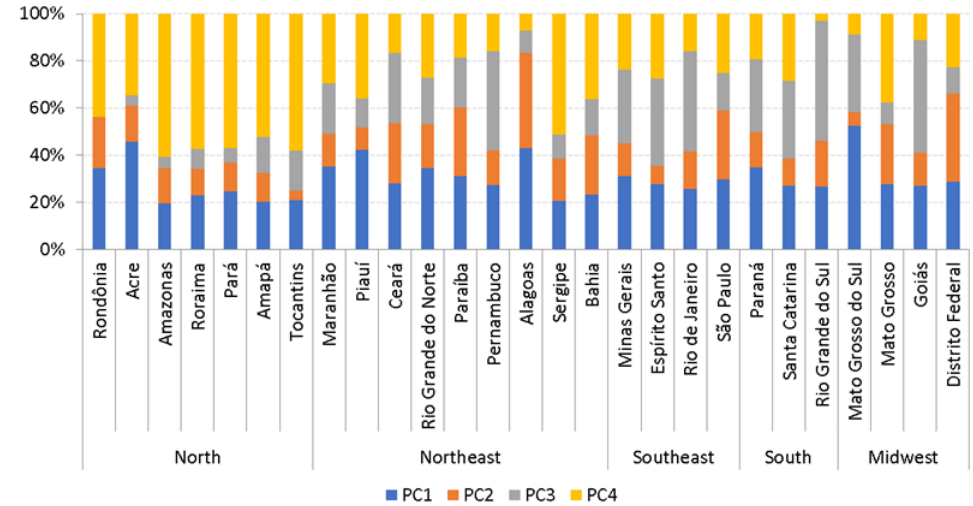
Figure 1. Distribution of smokers by price categories across states and regions.